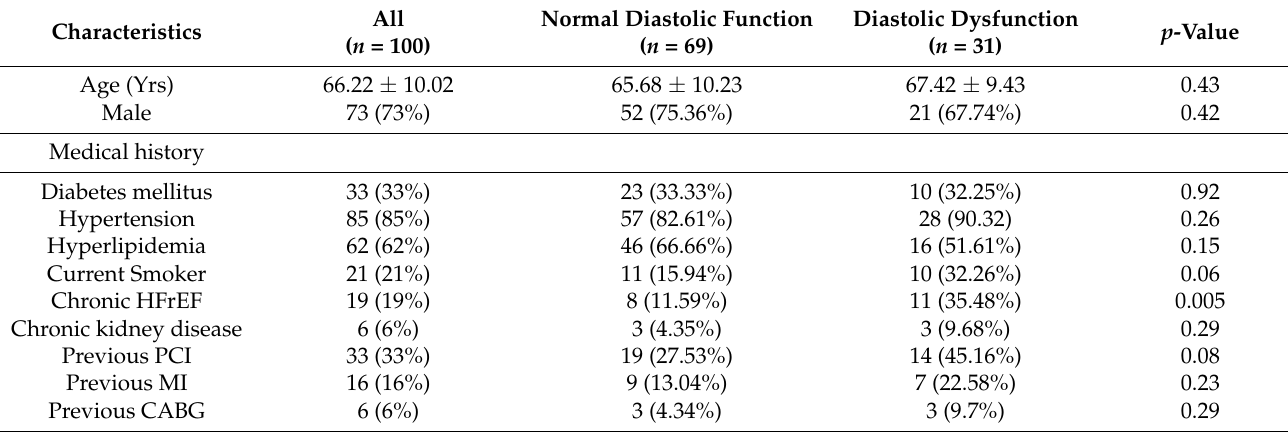
Table 1. Baseline characteristics of